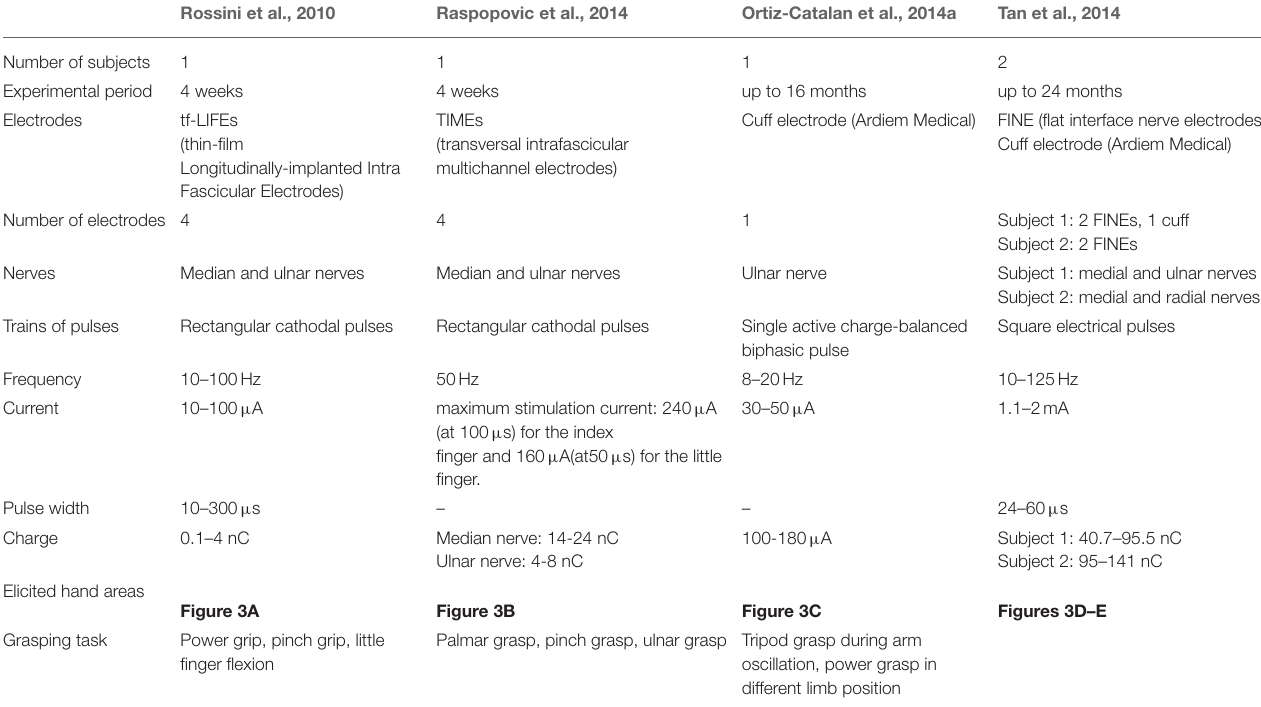
TABLE 2 | Summary of results on neural implant studies for sensory feedback